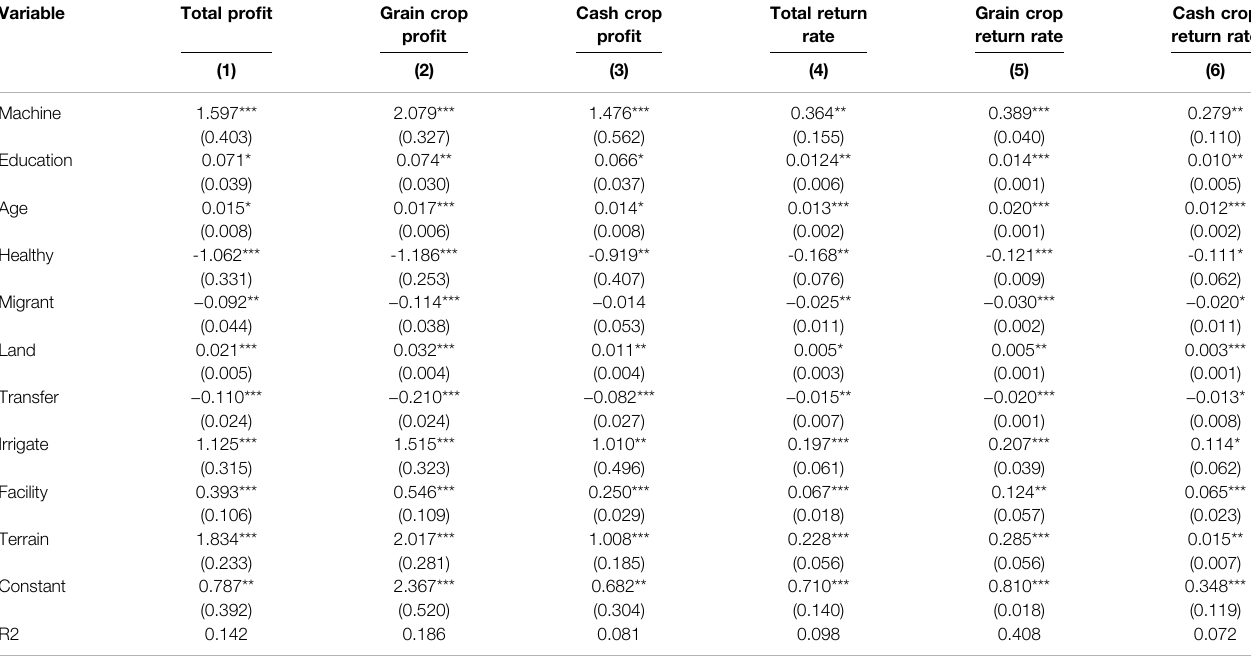
TABLE 3 | OLS estimation of the in fl uence of agricultural mechanization level on agricultural pro fi t and rate of return.